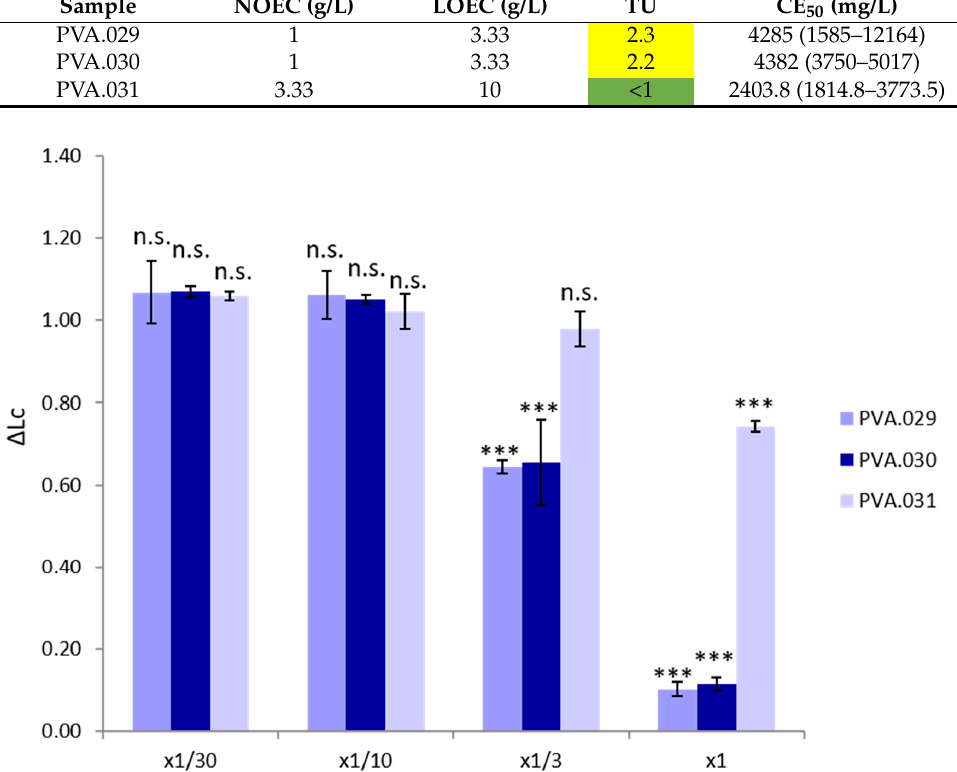
Table 3. Toxicity of different materials expressed as no observed adverse effects concentration (NOEC) and the lowest observed adverse effect concentration (LOEC); toxic units (TU); 50% decrease in larval growth with respect to the control (EC 50 ).